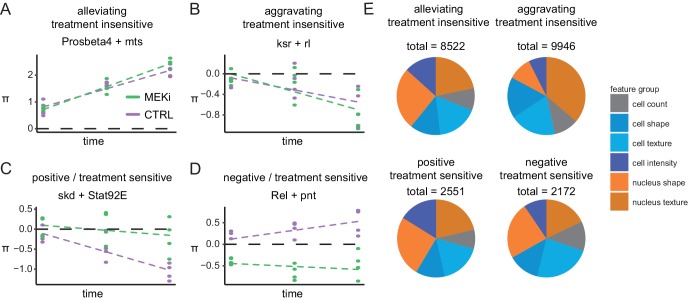
Genetic interactions rewire over time.(A–D) Examples of time- and treatment-dependent genetic interactions: (A) alleviating treatment-insensitive interaction of Prosbeta4 (proteasome) and mts (cytoskeleton), treatment invariant and increasing over time, (B) aggravating- treatment-insensitive interaction of ksr and rl (both Ras signaling), treatment invariant and decreasing over time, (C) positive treatment-sensitive interaction of skd (mediator complex) and Stat92E (STAT receptor), lifted from synthetic lethal to non-interacting by treatment, (D) negative treatment-sensitive interaction of Rel (innate immunity) and pnt (Ras signaling), π-scores decreased by the treatment. (cell count, FDR < 0.1, robust f.test followed by multiple testing correction after Benjamini Hochberg). Dashed lines are trendlines for each treatment group. (E) Interaction counts after MODIFI. Interactions (FDR < 0.1) are counted for 16 features, grouped into cell count, shape, texture and intensity within cell and nucleus.